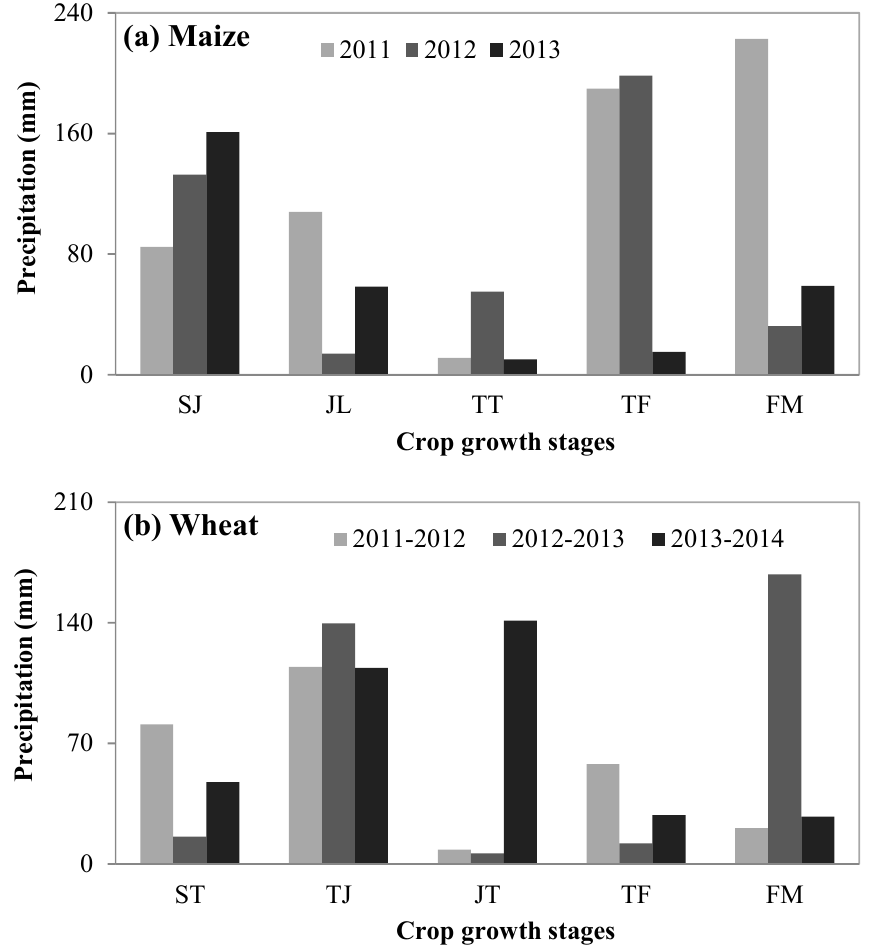
Figure 1. Precipitation distributions at di ff erent crop growth stages in 2011 − 2014 winter wheat-summer maize rotation seasons. SJ indicates sowing-jointing stage; JL indicates jointing-ten leaf collar stage; TT indicates ten leaf collars-tasseling stage; TF indicates tasseling-grain filling stage; FM indicates grainfilling-maturity stage; ST indicates sowing-tillering stage; TJ indicates tillering-jointing stage; JT indicates jointing-tasseling stage.